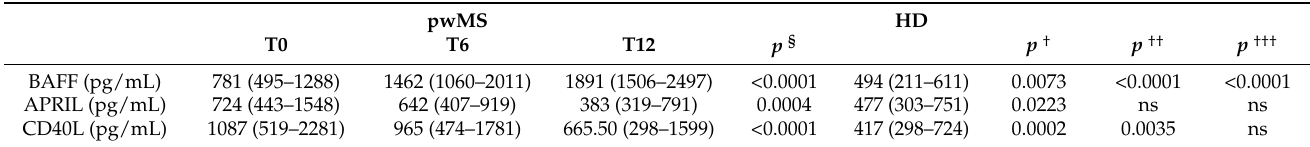
Plasma BAFF, APRIL and CD40L levels were longitudinally evaluated in pwMS at T0, T6 and T12. § : The non- parametric comparative Friedman test was used to compare medians between T0, T6 and T12. The longitudinal plasma BAFF, APRIL and CD40L values of pwMS were compared to the levels displayed by HD. † : Dunn’s multiple comparison post-test was used for comparing medians between T0 and HD; †† : Dunn’s multiple comparison post-test was used for comparing medians between T6 and HD; ††† : Dunn’s multiple comparison post-test was used for comparing medians between T12 and HD. pwMS: people with MS; HD: healthy donors; BAFF: B-cell-activating factor; APRIL: a proliferation-inducing ligand; CD40L: CD40 ligand; T0: before first infusion; T6: before second infusion; T12: before third